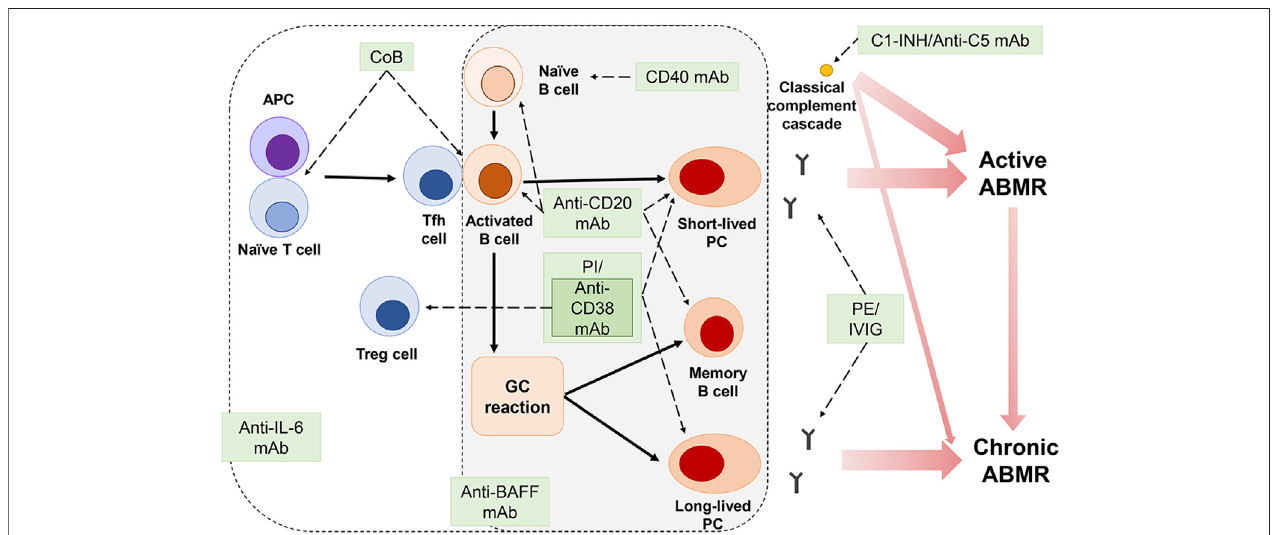
FIGURE 1 | Immune mechanisms of graft rejection and therapeutic targets.Plasma exchange (PE) and intravenous immunoglobulin (IVIG) remove DSAs. Anti-CD20 monoclonalantibody(mAb) eliminatesB cells,memory Bcells, and short-lived plasmacells (PC).However,PE, IVIG,and anti-CD20mAb areinsuf fi cient to inhibit long-lived PCs that continuously produce antibodies. Although proteasome inhibitors(PI), bortezomib and car fi lzomib, can eliminatePCs,theexpansion of bortezomib-induced germinalcenter (GC)BcellsandTfhcellsortheappearanceofcar fi lzomib-resistantbonemarrowPCsmaymitigatetheeffectofPI.Anti-CD38mAbdepletesPCs,butitcanalsosuppressT regulatory (Treg) cells. Combination strategies using costimulation blockers, anti-interleukin 6 (IL-6), and anti-B-cell-activating factor (BAFF) mAB could further enhance the effectiveness of rejection therapies in blocking antibody production and preventing graft damage by generating synergy of the